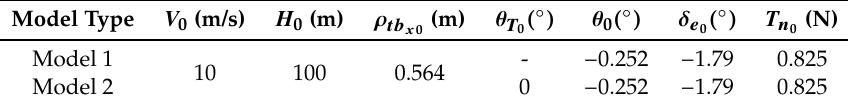
Table 3. Steady level trim flight condition for Models 1 and